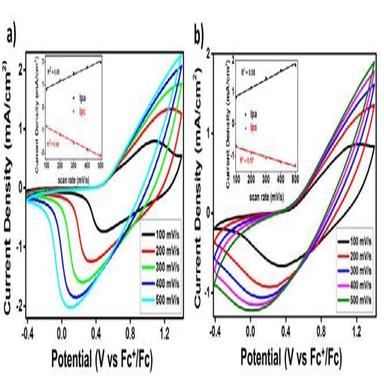
Cyclic voltammogram of the a) CH/p(BT) and b) CH/rGO/p(BT) on ITO electrode in 0,1 M LiClO4/ACN at various scan rates. Insert graphics show anodic and cathodic peak currents versus scan rate graphs for composites.